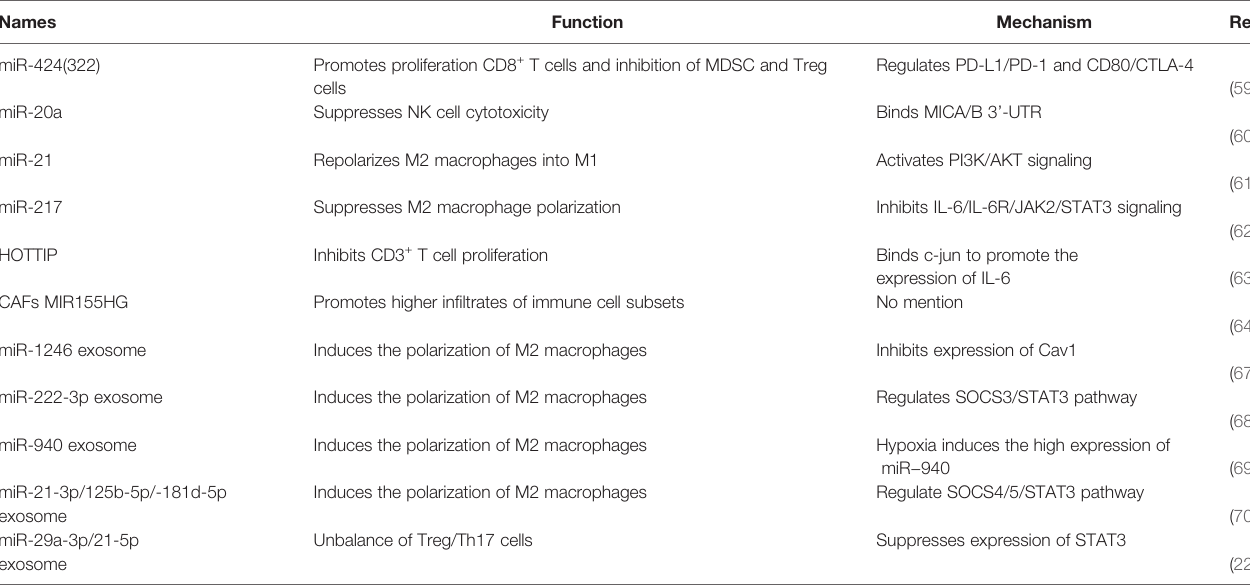
TABLE 2 | miRNAs and lncRNAs regulate immune cells in OvCa TME.